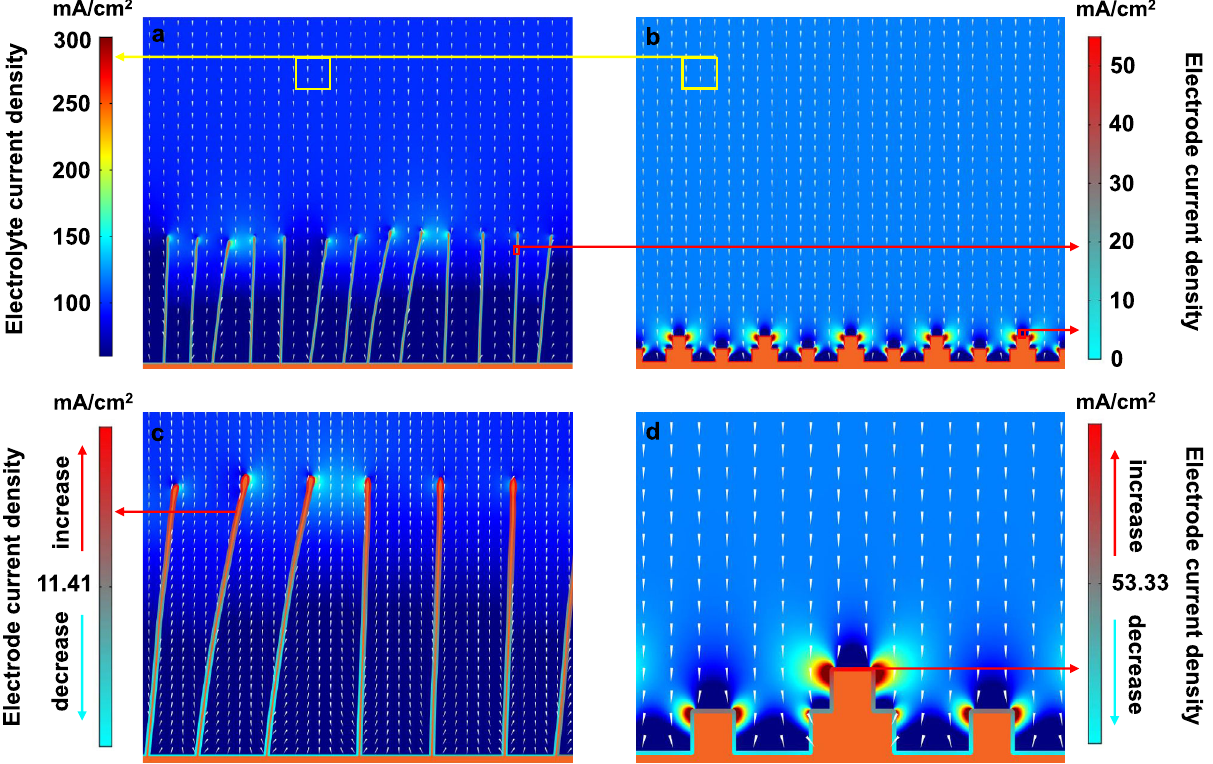
Fig. 6 COMSOL multiphysics simulations. a , c Electrode current density and electrolyte current density distribution of DVL-Cu at 100 mA cm − 2 . b , d Electrode current density and electrolyte current density distribution of Cu 2 O nanocubes at 100 mA cm − 2 . The electrode current density and electrolyte current density (in a and b ) correspond to the left and right legends, respectively. The electrode current densities in ( c ) and ( d ) correspond to the left and right legends, respectively. The conical arrows represent the electrolyte current density